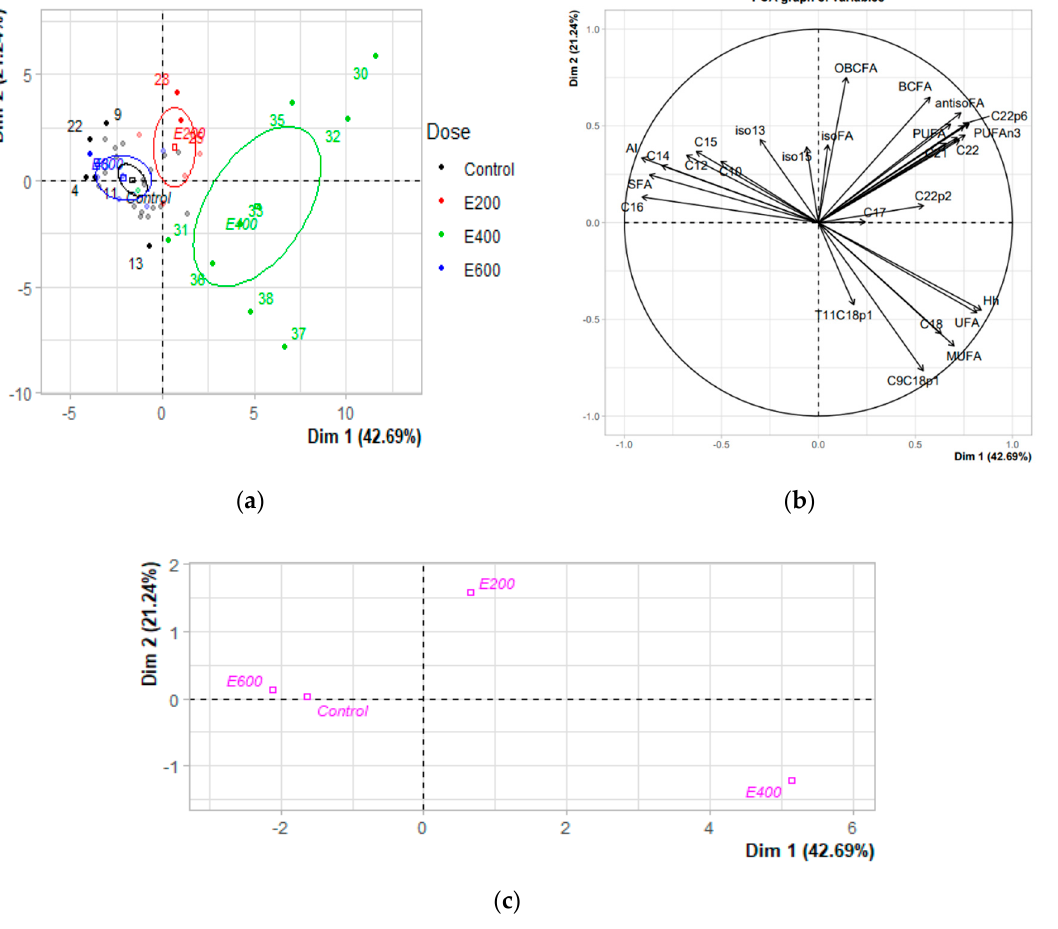
Figure 3. ( a ) Individuals factor map (PCA); ( b ) variable’s factor map (PCA); ( c ) qualitative factor map (PCA). The labeled factors are those the best shown on the plane, in which: control (0 g/d FAF); E200 (200 g/d FAF as fed); E400 (400 g/d FAF as fed); and E600 (600 g/d FAF as fed). Table 5. Eigen analysis and correlations between variables and PC.